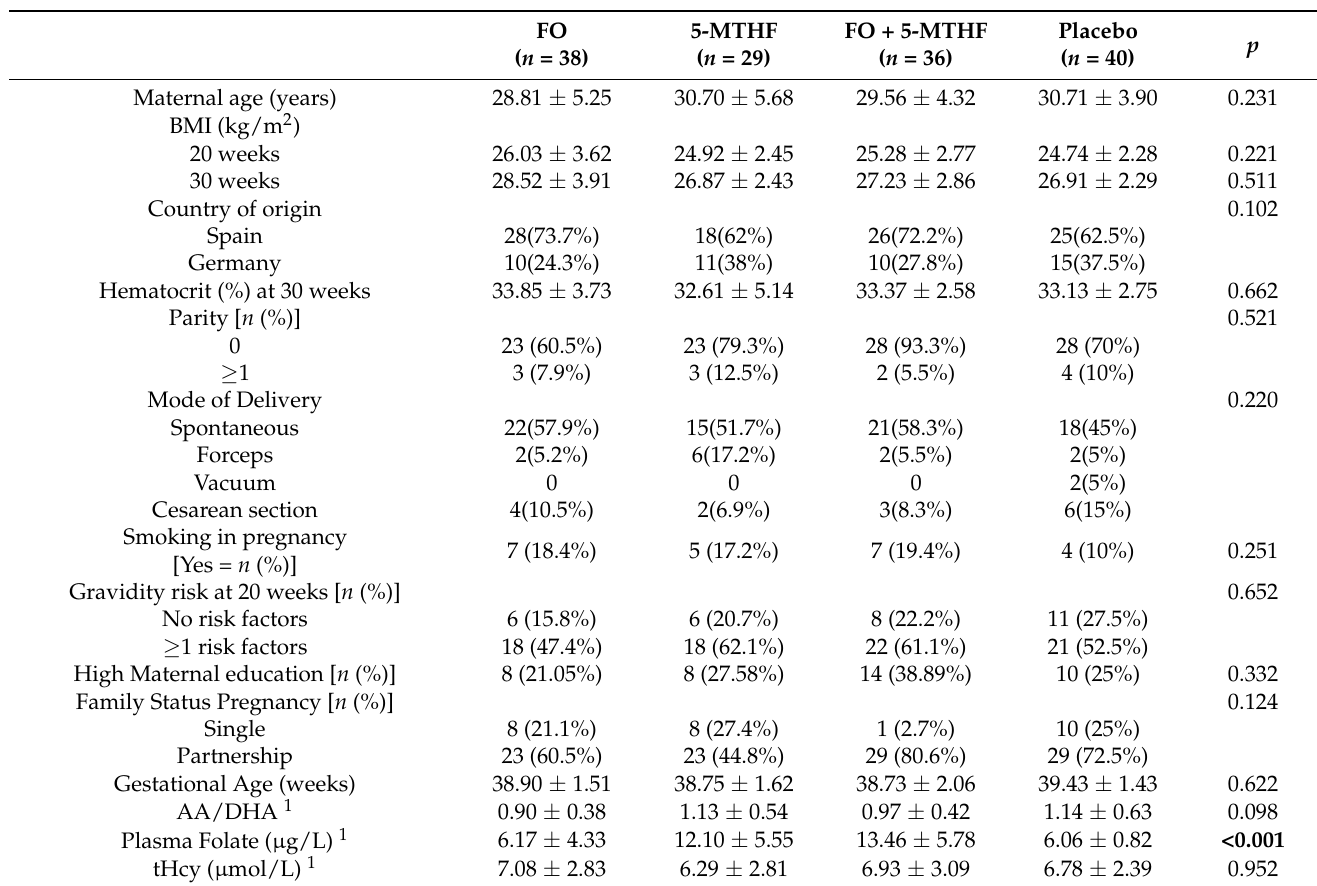
Table 1. General characteristics of the studied